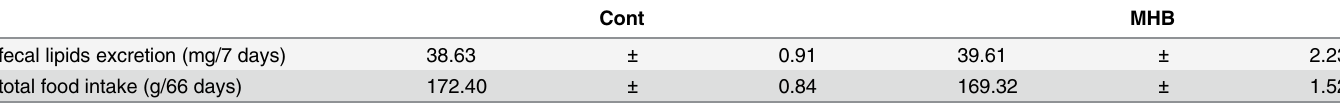
Table 1. Total food intake of mice fed on HFD with or without MHB supplementation and the effect of MHB on fecal lipid content.